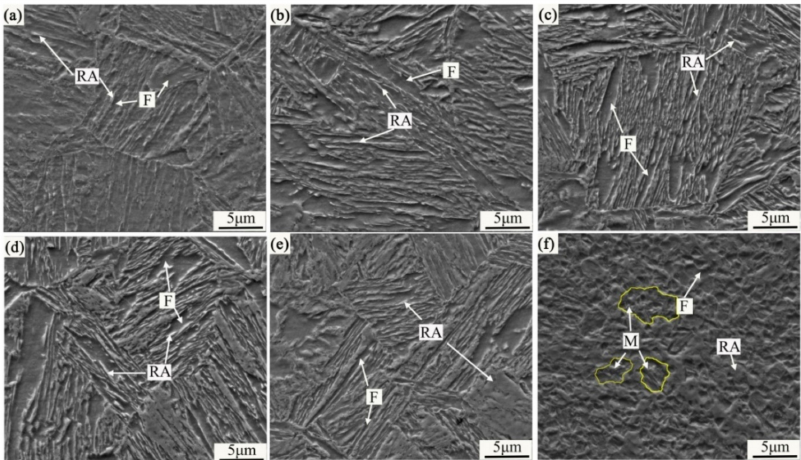
Figure 4. SEM micrographs of experimental steels at different annealing temperatures. ( a ) 600 ◦ C,